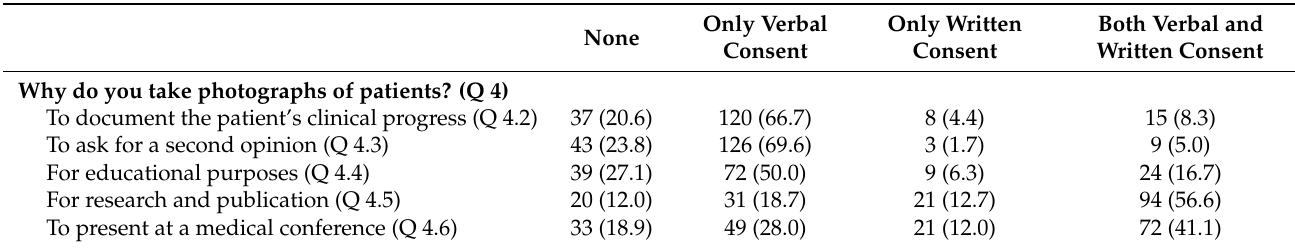
Table 3. Types of